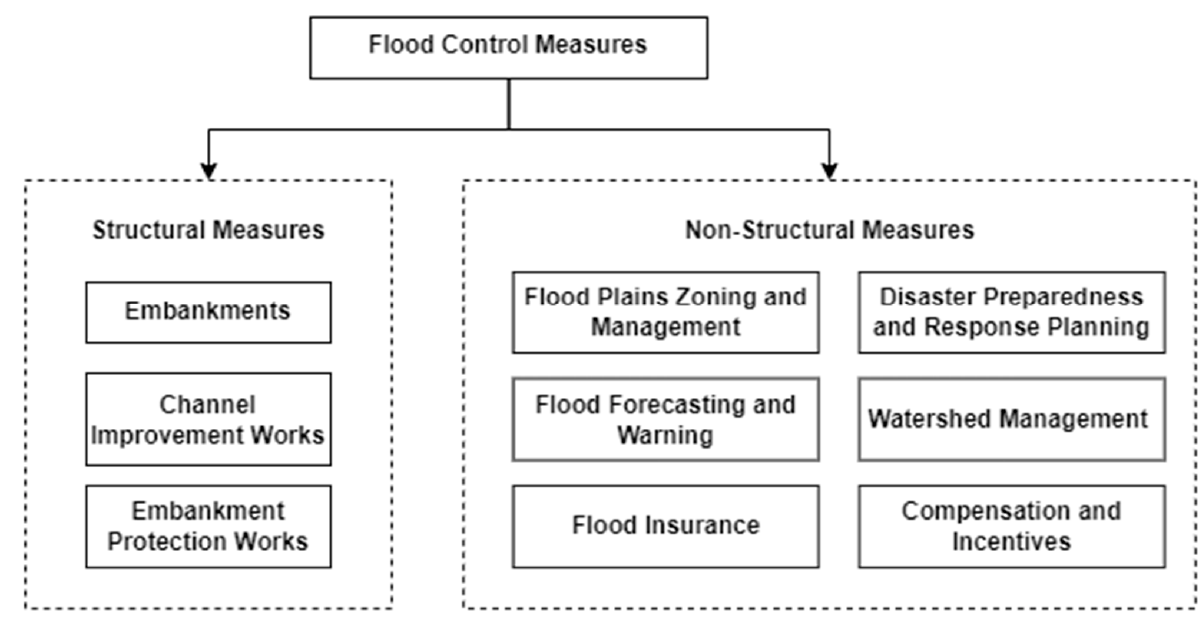
Figure 13. The flood control measures.